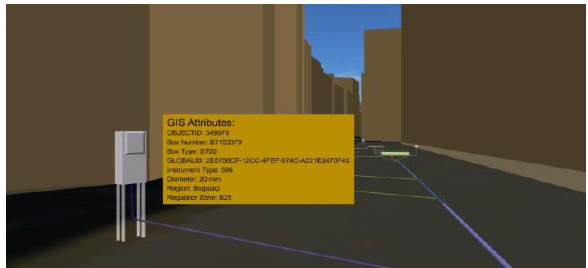
Figure 14. 3D visualization of underground utility